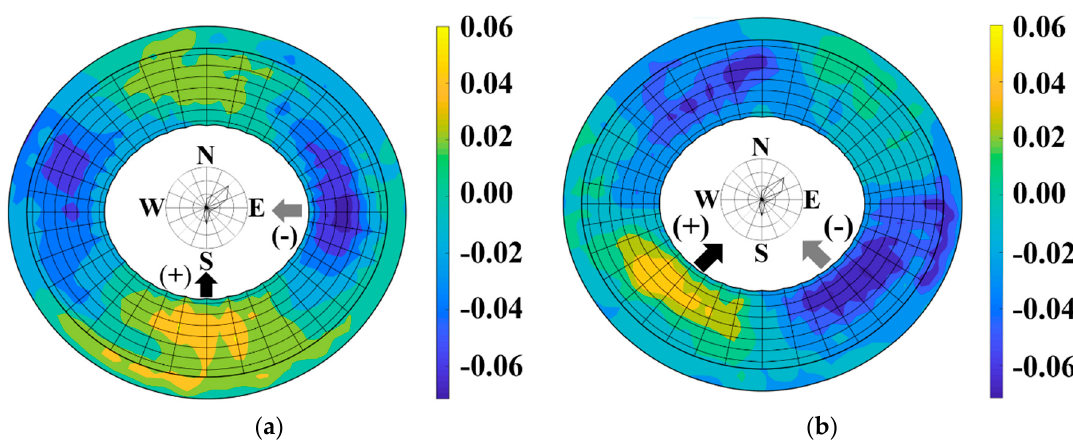
Figure 13. Distribution characteristics of the second and third spatial modes: ( a ) EOF 2 ; ( b ) EOF 3 .